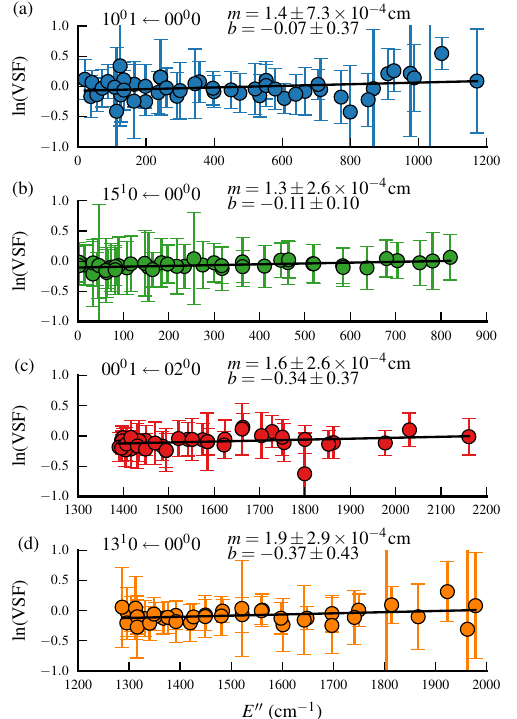
Figure 1. Example of ln ( VSF ) vs. E (cid:48)(cid:48) relationships (see Eq. (5)) for CO 2 bands that passed all quality criteria and were used to retrieve T . The four transitions are (a) 10 0 1 ← 00 0 0, (b) 15 1 0 ← 00 0 0, (c) 00 0 1 ← 02 0 0, and (d) 13 1 0 ← 00 0 0. These are from ACE-FTS oc- cultation ss5211 on 31 July 2004, over the Middle East, at an alti- tude of 38.1km. Labelled for each band are the transition, slope m , and y intercept b of the best fit